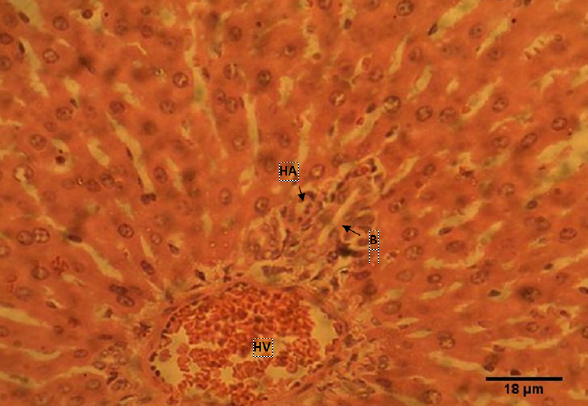
Fig. 4. Histological appearance of liver of rat given 0.25 mg/kg body weight of quail egg orally for 63 days, showing no obvious lesions. Note the hepatic lobules with normal hepatocytes arranged in chords radiating towards the portal areas which show the hepatic artery (HA), hepatic vein (HV) and bile duct (B); Hematoxylin & Eosin (H&E) × 400